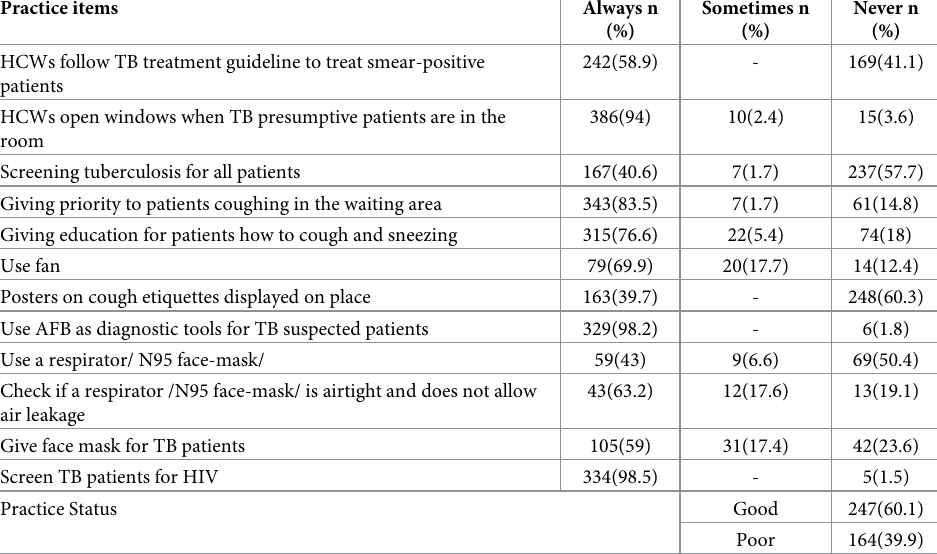
Table 2. The distribution of healthcare workers by their practices of TBIC measures in public hospitals; Gamo Gofa Zone, Ethiopia, 2019. Practice